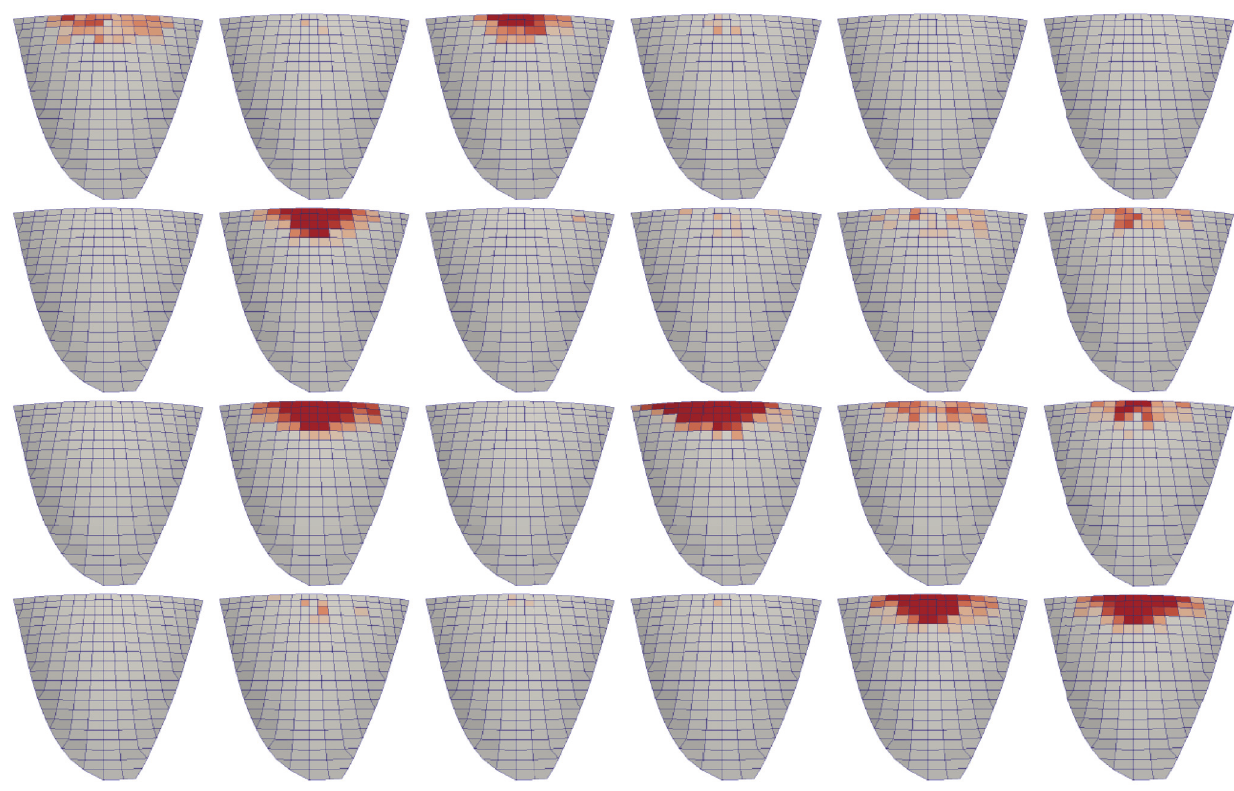
Figure 10: Distribution of third crack on upstream face; top left: Sim-1; first row: 1 to 6; bottom right: Sim-24.